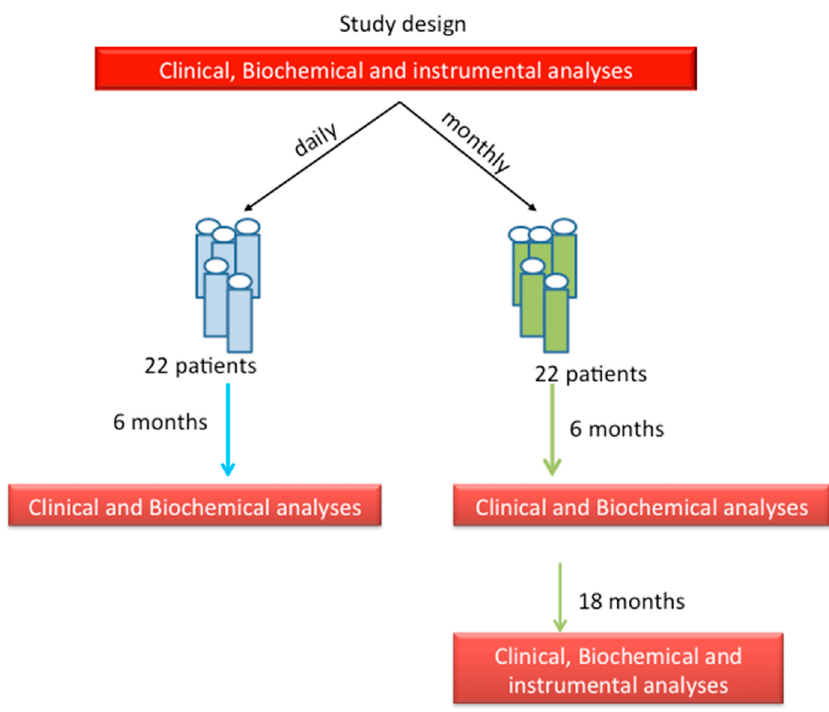
Figure 1. Description of study design.